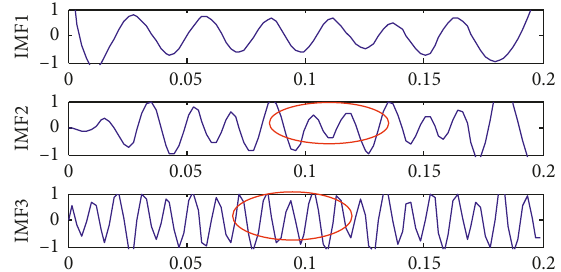
Figure 2: The calculation results by the EMD